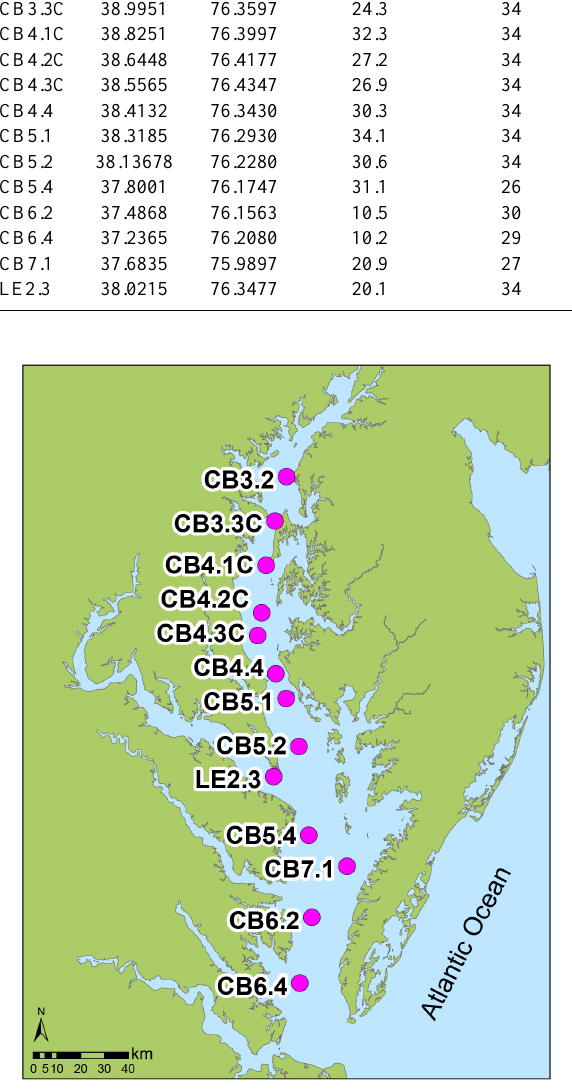
Figure 2. Location of the CBP water quality monitoring stations used in this